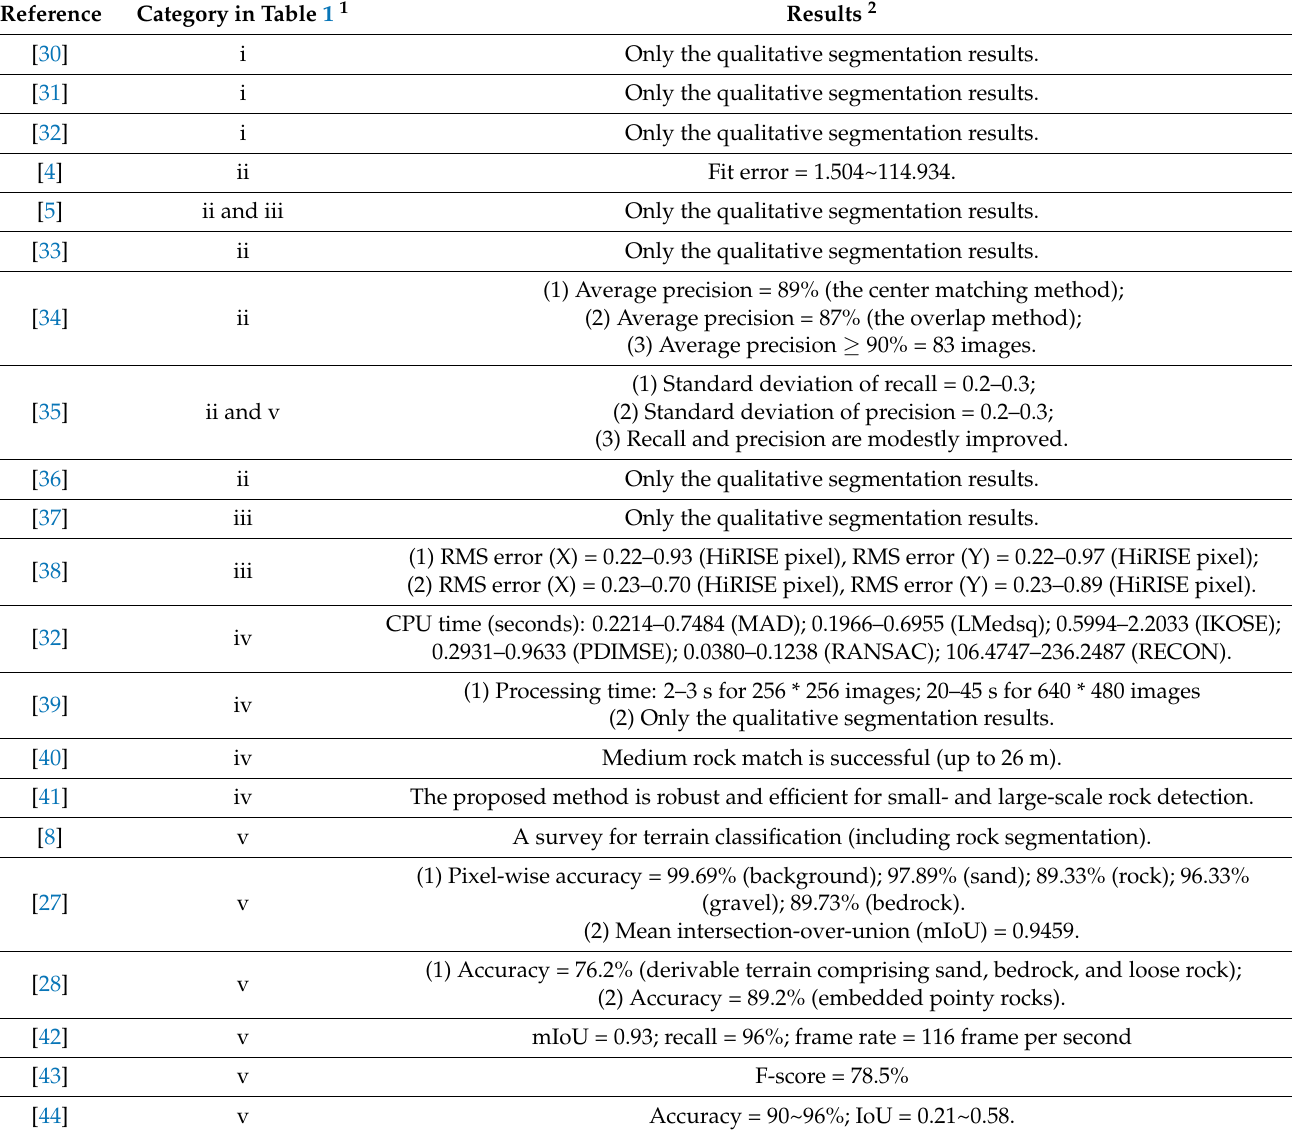
Table 1. The detailed results of the related studies of Table